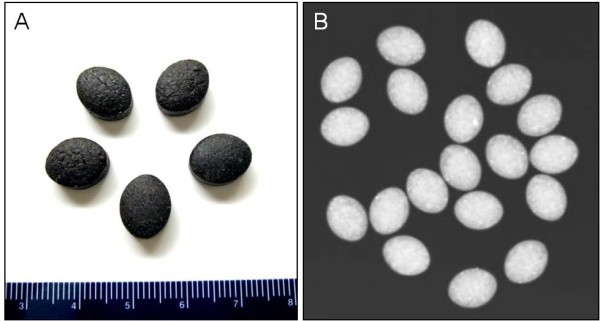
Jambrulin tablets. A. The tablets are 1.25 cm black, ovoid pills (ruler is in cm). B. X-ray shows diffusely opaque Jambrulin pills with flakes of high attenuating material.